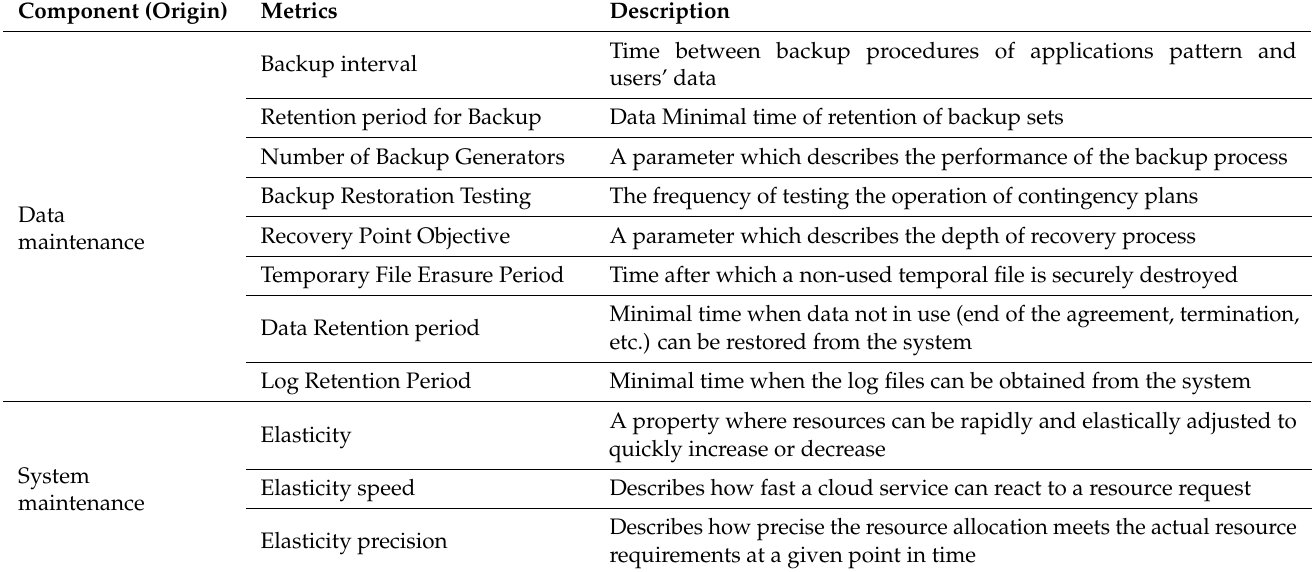
Table 4. On-demand SSLA components (SLO type and maintenance measures).